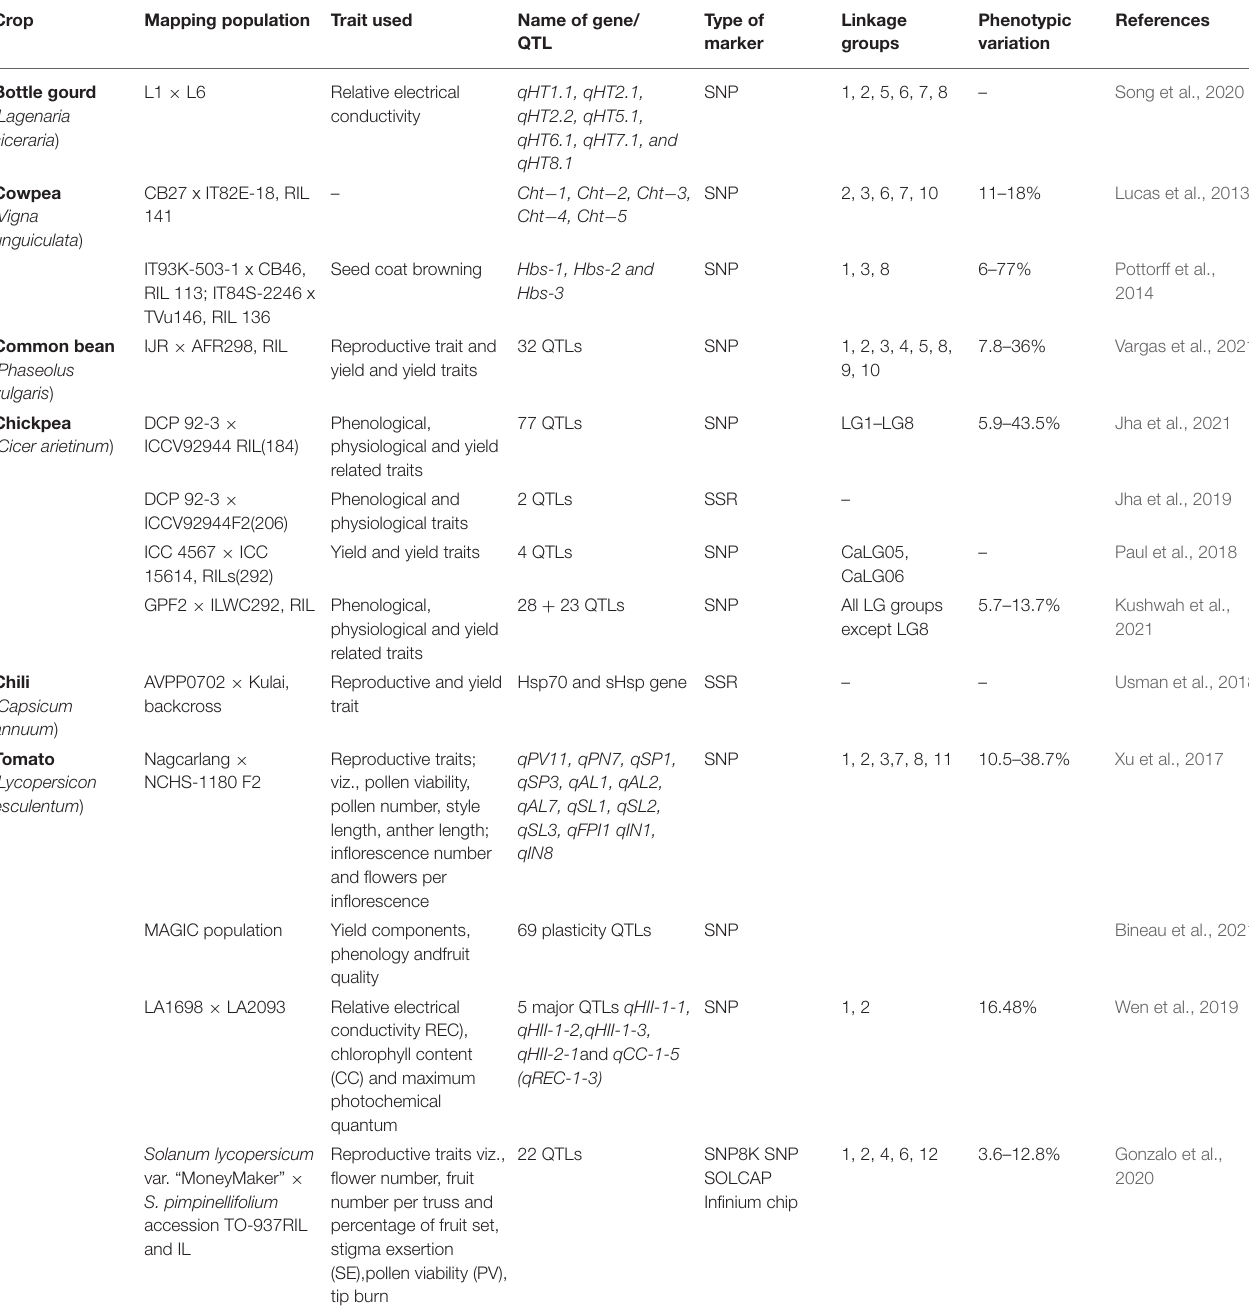
TABLE 5 | List of selected QTLs contributing to heat tolerance in vegetable crops.